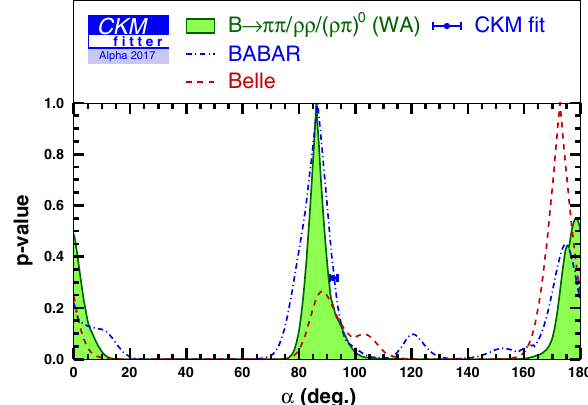
Fig. 50 Combined constraint on α from the SU ( 2 ) isospin analysis of B → ππ , B → ρρ and B 0 → (ρπ) 0 systems using BaBar data ( blue curve ) and Belle data ( red curve ). The green shaded area represents the determination based on the world average for these observables. The interval with a dot indicates the indirect determination introduced in Eq. (2)